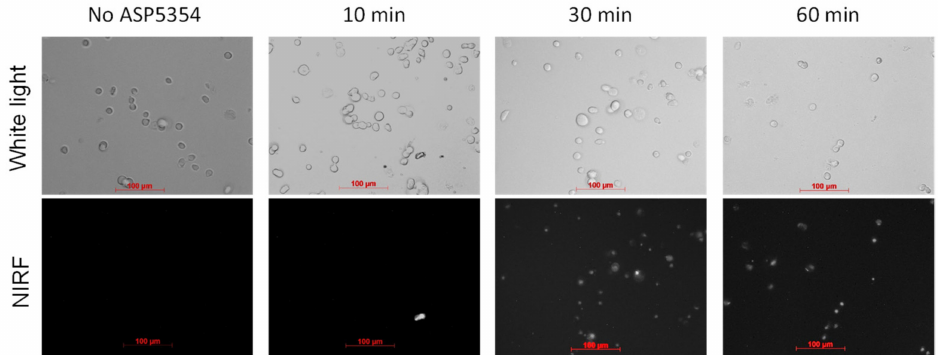
Figure 6. Near-infrared fluorescence (NIRF) imaging of ASP5354 uptake in RenCa cells. NIRF images of cells with 60 s exposure time after incubation with ASP5354 (24 µ M) for 10, 30, or 60 min. NIRF is displayed in